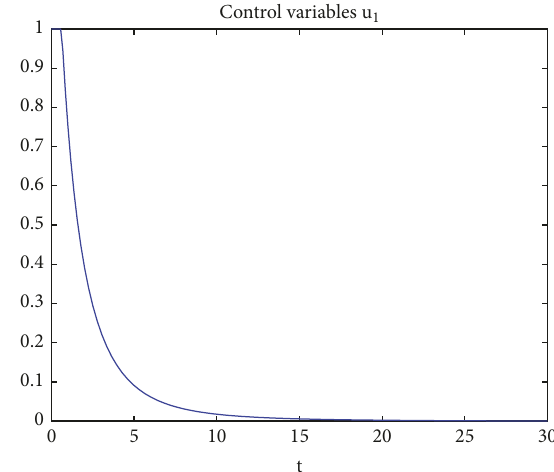
Figure 4: Optimal control function 𝑢 1 (𝑡) for a controlled